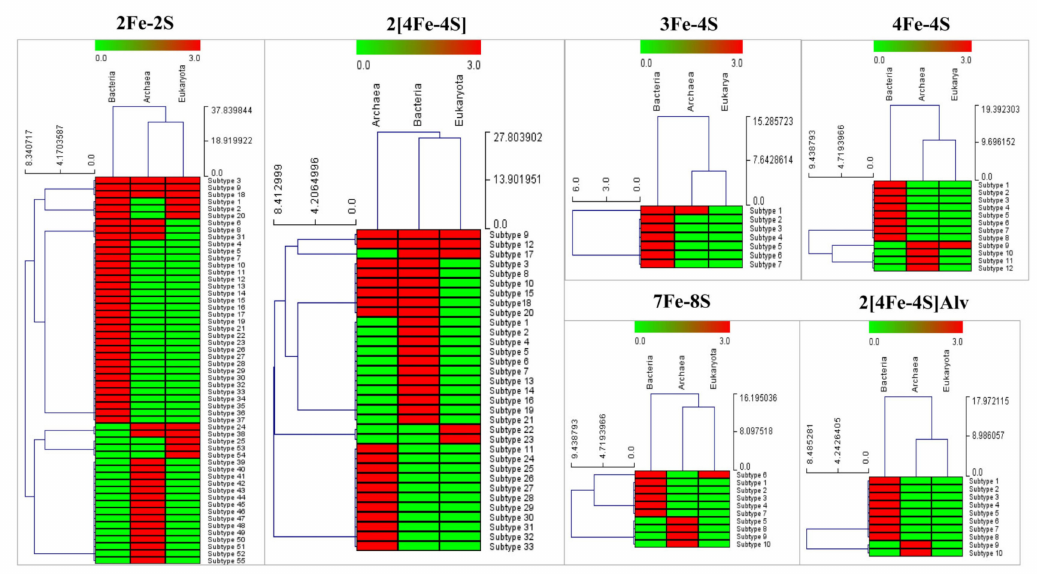
Figure 4. Heat map figure representing the presence (red) and absence (green) of ferredoxin subtypes in Archaea, Bacteria and Eukarya. Ferredoxin subtypes form the vertical axis and domains of life forms the horizontal